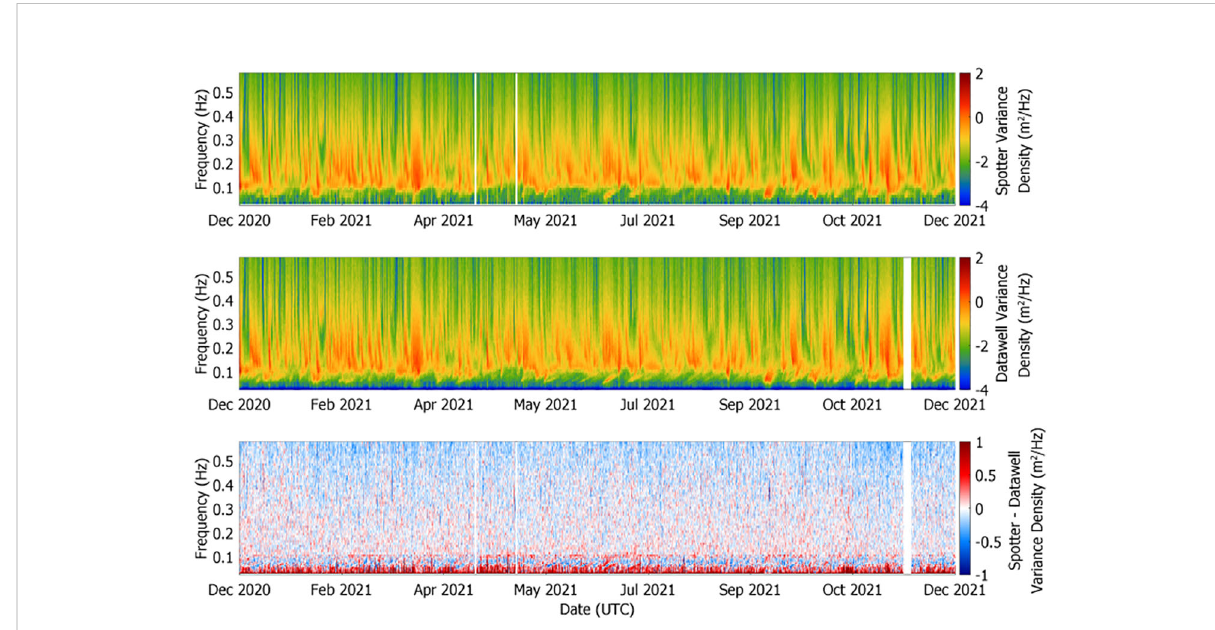
FIGURE 6 Time series displaying wave energy against frequency recorded by the Spotter (top) and Datawell (center) wave buoys on a log